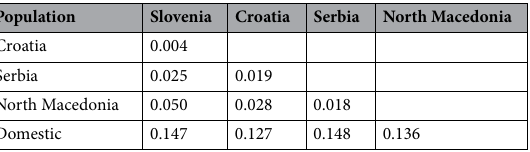
Table 2. Pairwise values of F ST among European wildcat populations and domestic cats. All F ST values are significant.